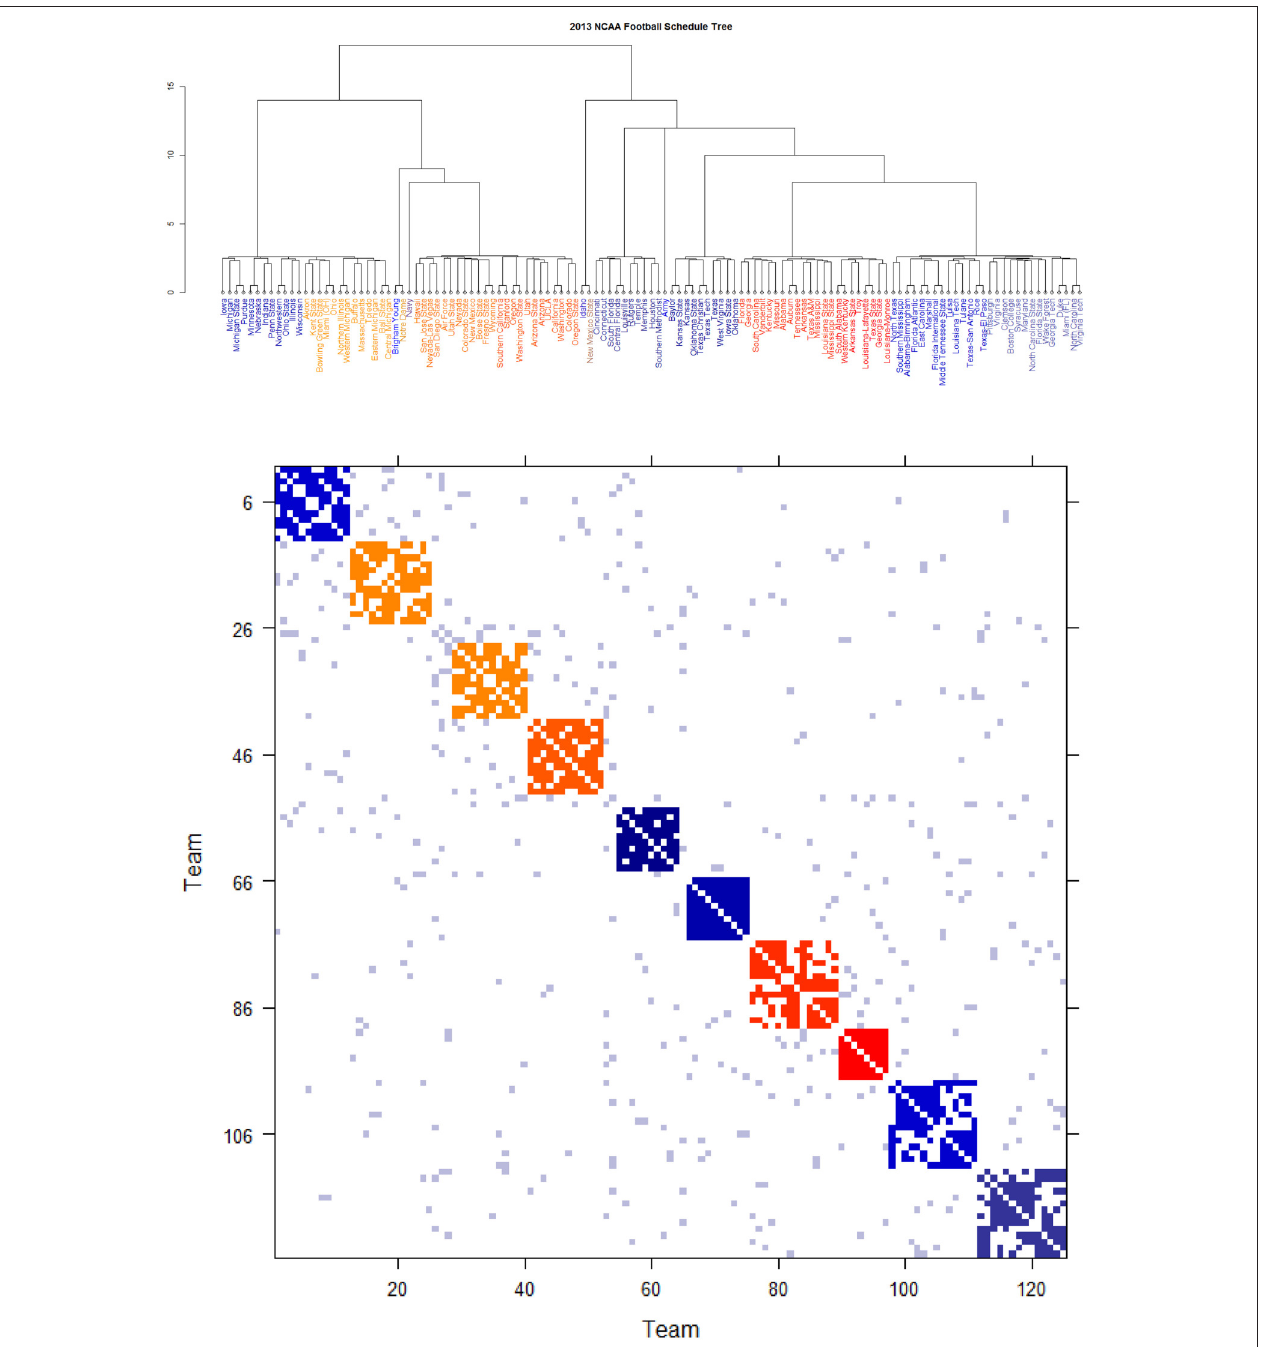
FIGURE 7 | Schedule DCG tree and its induced schedule matrix S 0 of NCAA football data on year 2013: (Upper panel) DCG tree and (Lower panel) Parisi adjacency matrix with colored diagonal blocks marking the intra-conference games for the real conferences, and off-diagonal inter-conference games are marked in gray. The six independent teams are scatted on the tree. Conferences, from blue to red, are ACC, American, Big 12, Big Ten, Conference-USA, Independent schools, Mid-American, Mountain West, Pac 12, SEC, and Sun